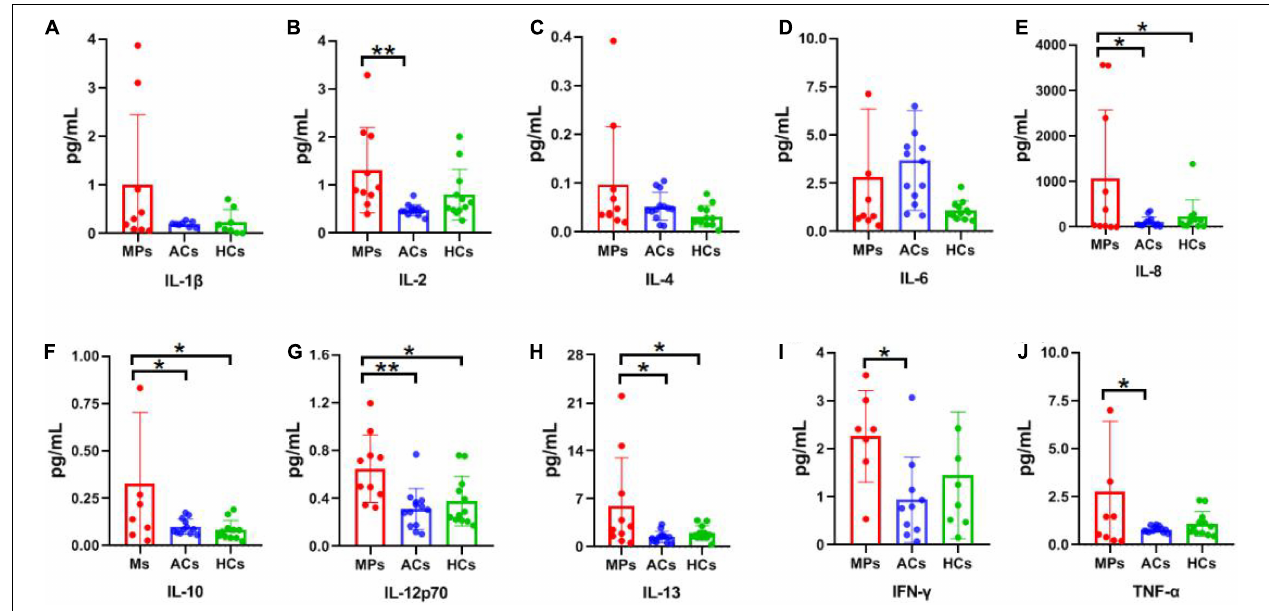
FIGURE 3 | Cytokine detection results of SPs, ACs, and HCs. Red, blue, and green columns refer to SPs (10 individuals), ACs (13 individuals), and HCs (12 individuals), respectively. Unit: pg/ml. (A) IL-1 β . (B) IL-2. (C) IL-4. (D) IL-6. (E) IL-8. (F) IL-10. (G) IL-12p70. (H) IL-13. (I) IFN- γ . (J) TNF- α . Data are presented as means ± SEM. * P < 0.05, ** P <